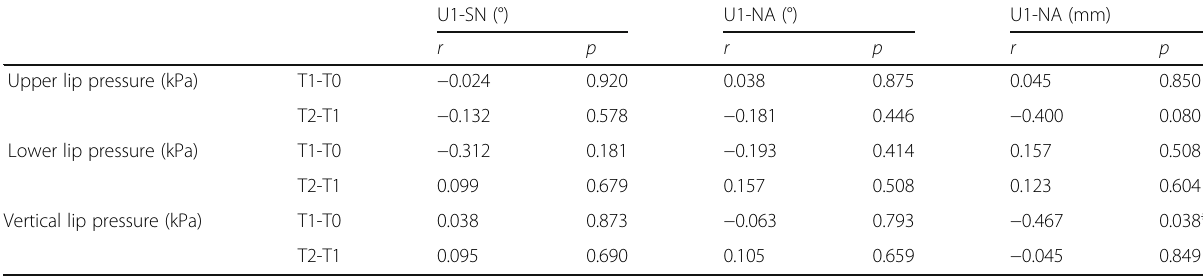
Table 6 Evaluation of the relationship between the upper incisor inclination and pressure